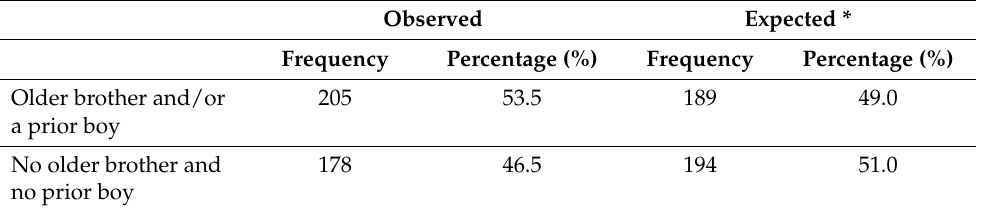
Table 6. The observed and expected distribution of siblings and previous births in all RPL patients according to sex. All previous births before sRPL were included ( n =